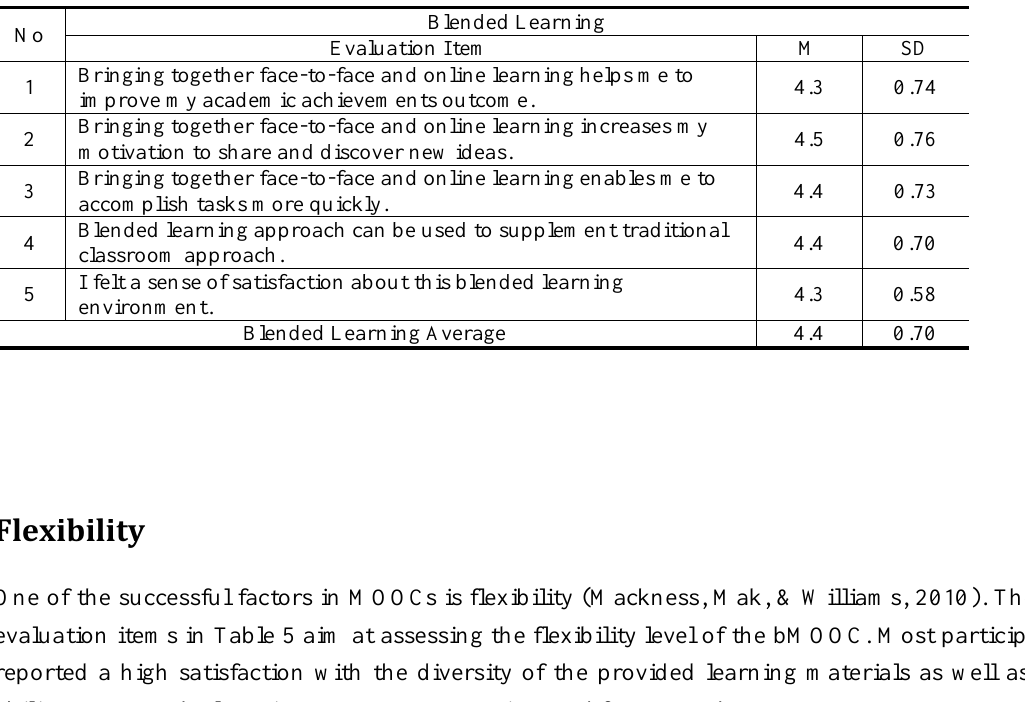
Descriptive Results of Blended Learning